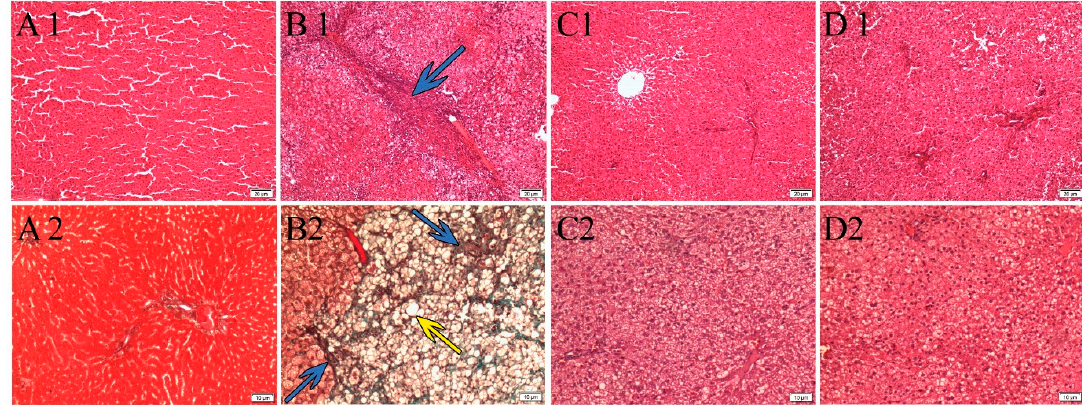
Figure 1. Photographs of the liver tissues stained by H&E ( A1 , B1 , C1 , D1 ) and by Masson’s trichrome staining ( A2 , B2 , C2 , D2 ), all under magnification (100×), showing the effect of metformin and P. niruri treatment on the liver histology of non-alcoholic fatty liver disease (NAFLD) rats. ( A1 , A2 ) showing normal architecture of liver tissue without any sign of steatosis in the normal control group which received normal diet ; ( B1 , B2 ) high-fat diet HFD group which represents untreated NAFLD rats, showing micro and macro steatosis with fibrosis; ( C1 , C2 ) showing improvement in liver histology of NAFLD rats which were treated with metformin, and ( D1 , D2 ) showing improvement in liver histology of NAFLD rats which were treated with 50% methanolic extract (ME) of P. niruri. Yellow arrow refers to hepatic steatosis, while blue arrow refers to hepatic fibrosis.